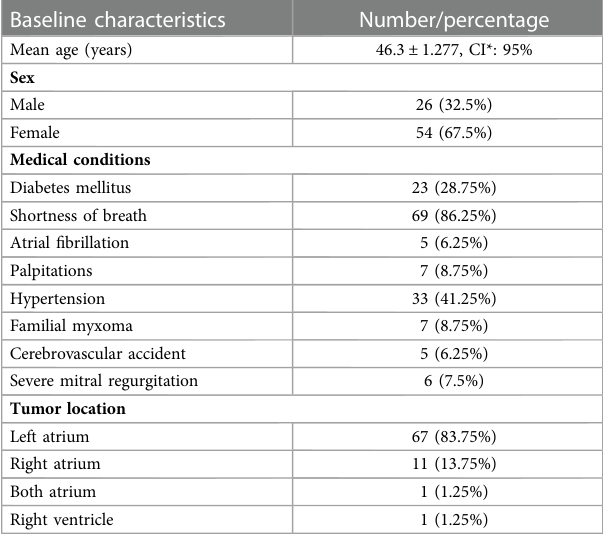
TABLE 1 The baseline characteristics of the patients with myxoma. Baseline